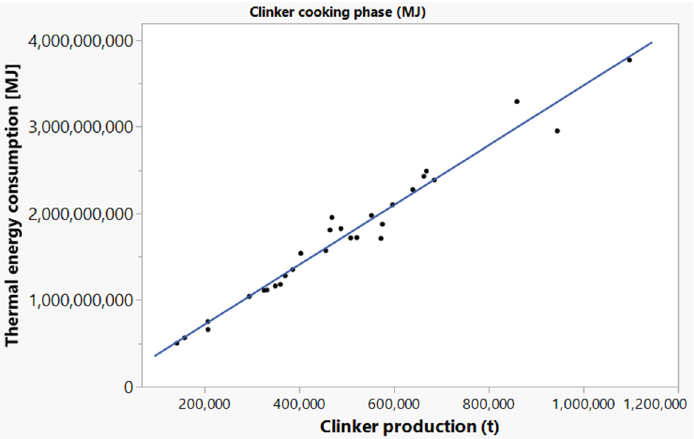
Figure 20. NACE 23.51: linear regression of electric consumption of the clinker grinding phase.